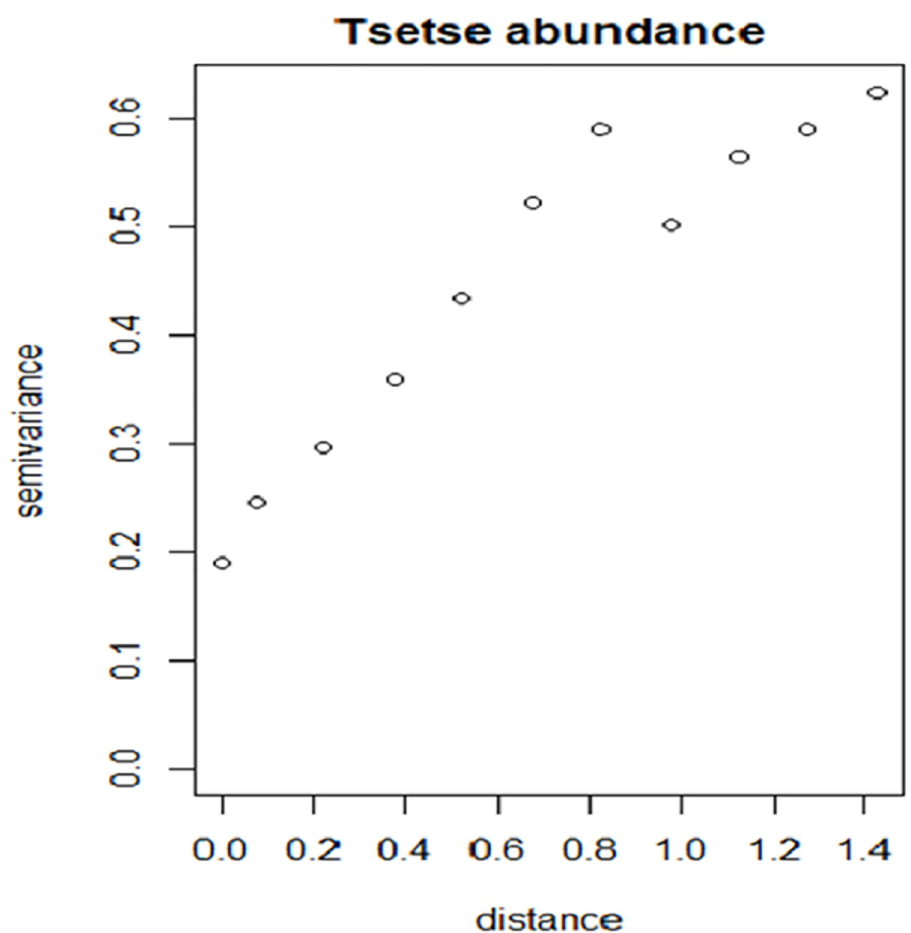
Fig 9. Residual variogram of the Pearson residuals based on the Poisson regression model (reveals the existence of spatial autocorrelation within the residuals). This residual variogram is an output of model fitting using R-tool under ordinary Poisson